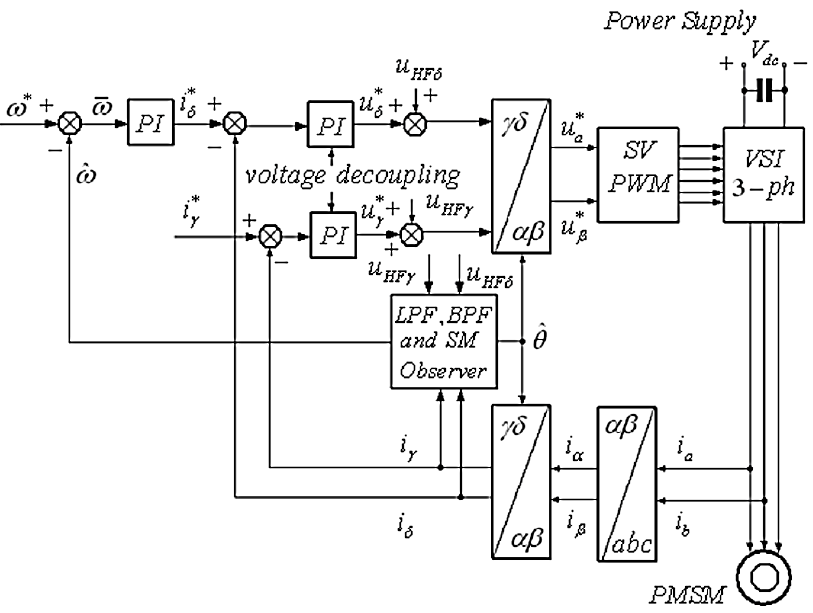
Figure 1. Block diagram of permanent magnet synchronous machine (PMSM) sensorless control based on voltage high-frequency injection (HFI) with LPF, BPF (low- and band-pass filtering) and a sliding mode observer (SMO) for speed and position.